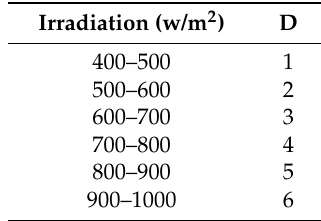
Table 1. Weighting factor corresponding to different